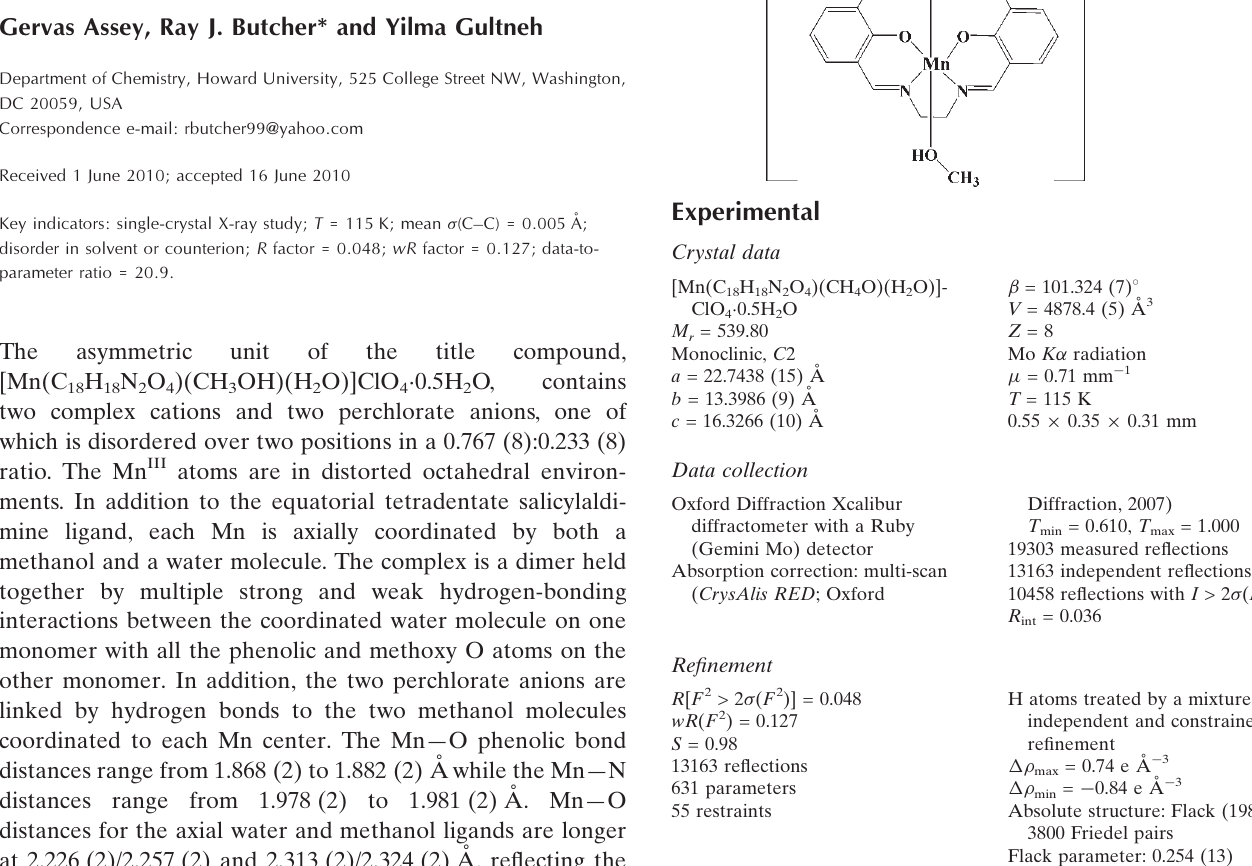
Experimental Crystal data